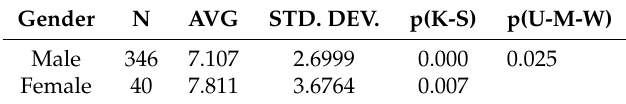
Table 4. Comparative study of commitment to the course between women and men.